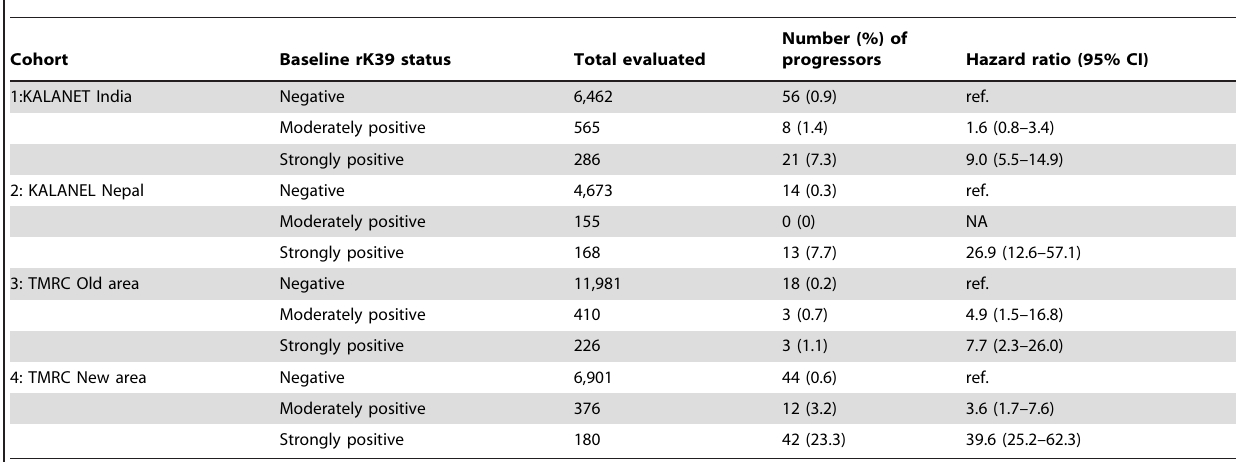
Table 3. Risk of progression to clinical VL by baseline rK39